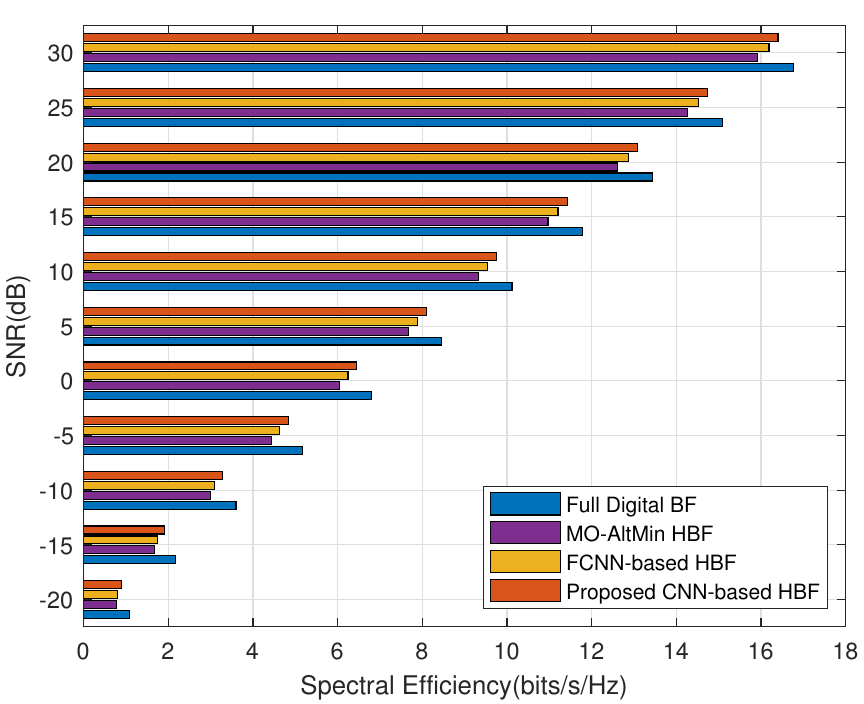
Figure 8. Comparison of spectral efficiency performance under different schemes in Rayleigh fading channel with N t = 128.